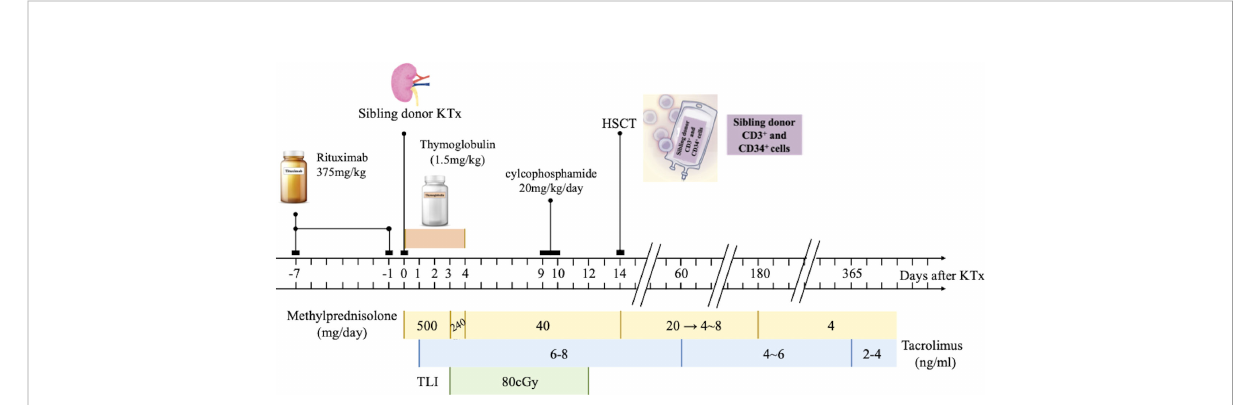
FIGURE 1 Kidney transplantation tolerance induction by sequential CD20 B cell-deleted, T Cell-deleted and sibling HSCT in Three Patients with end-stage renal disease (ESRD). Three patients with (ESRD) received a tolerance induction regimen consisting of rituximab, an ti- thymocyte globulin, total lymphoid irradiation, cyclophosphamide and hematopoietic stem-cell transplantation (HSCT). The kidney grafts were obtained from their siblings. Methylprednisolone (500 mg from Day 0 to Day 2,240 mg on Day 3, 40 mg from Day 4 to D ay 14) intravenously administered. Oral dose of 20 mg was given from Day 15 and reduced by 4 mg/day to 8 mg/day maintenance dose until six months after operation. After si x months, the maintenance dose was 4 mg/day. The target trough level concentration within two months was 6-8 ng/ml, within I year was 4-6 ng/ml and after 1 year was 2-4 ng/ml. KTx, kidney transplantation; ESRD, end-stage renal disease; HSCT, hematopoietic stem cell